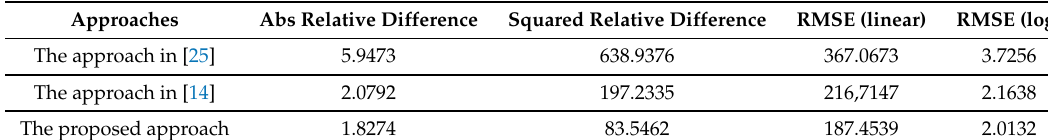
Table 3. Quatitative comparison on the aspects of accuracy and efficiency.